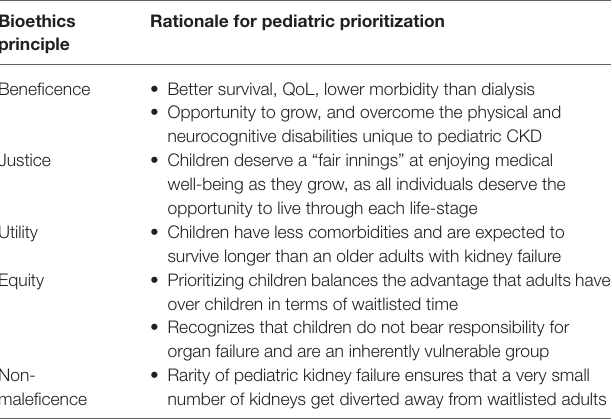
TABLE 1 | Ethical principles supporting pediatric prioritization in deceased donor kidney